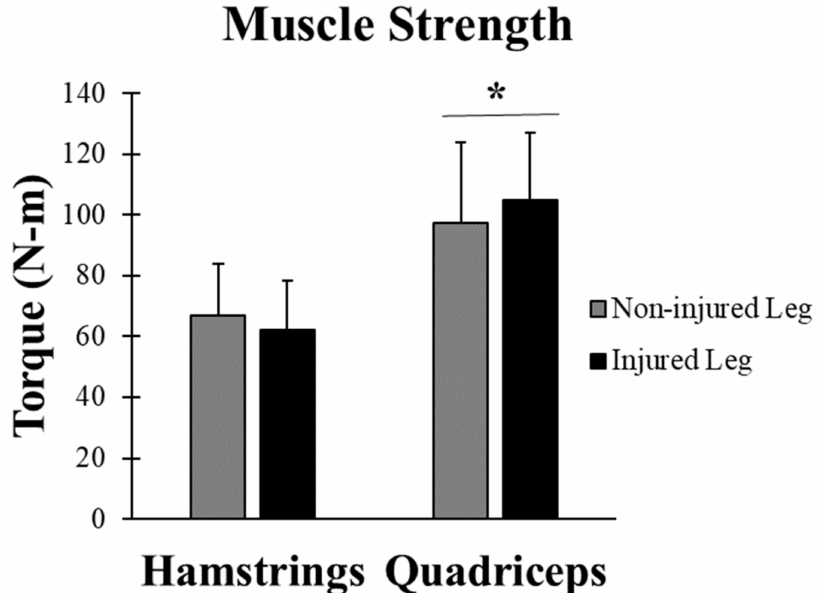
Figure 3. The muscle strength of the hamstrings and quadriceps. There was no significant difference between the injured and non-injured legs ( p > 0.05), but there was a significant difference between the hamstrings and the quadriceps ( p < 0.05). Values are means (SD). * represents significant difference ( p ≤